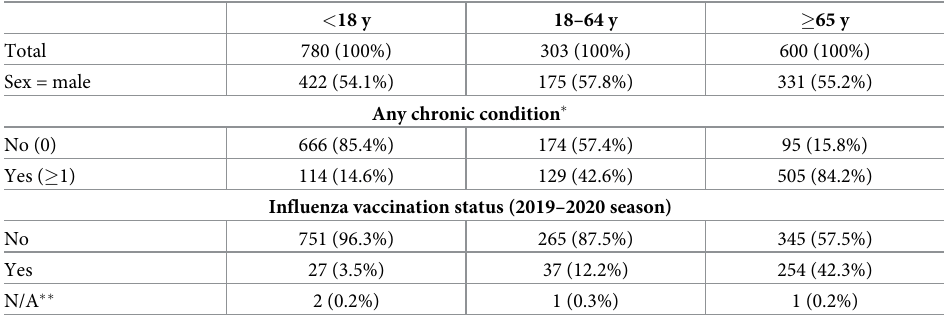
Table 1. Patients’ characteristics stratified by